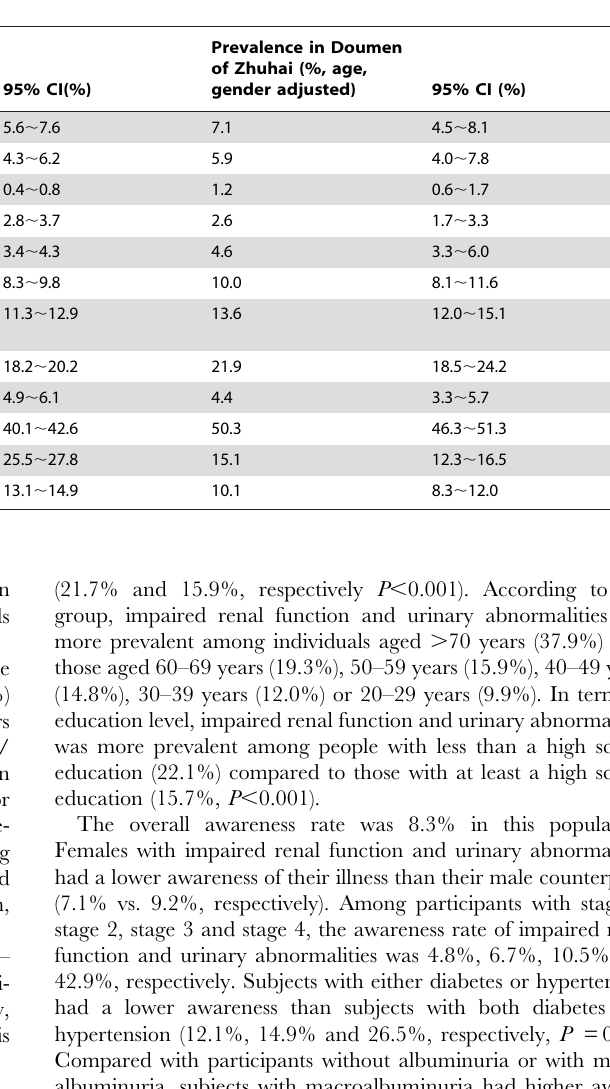
Table 2. Comparison of prevalence of adjusted indicators of kidney damage and related diseases between Doumen (a rural area of Zhuhai) and Guangzhou (urban data